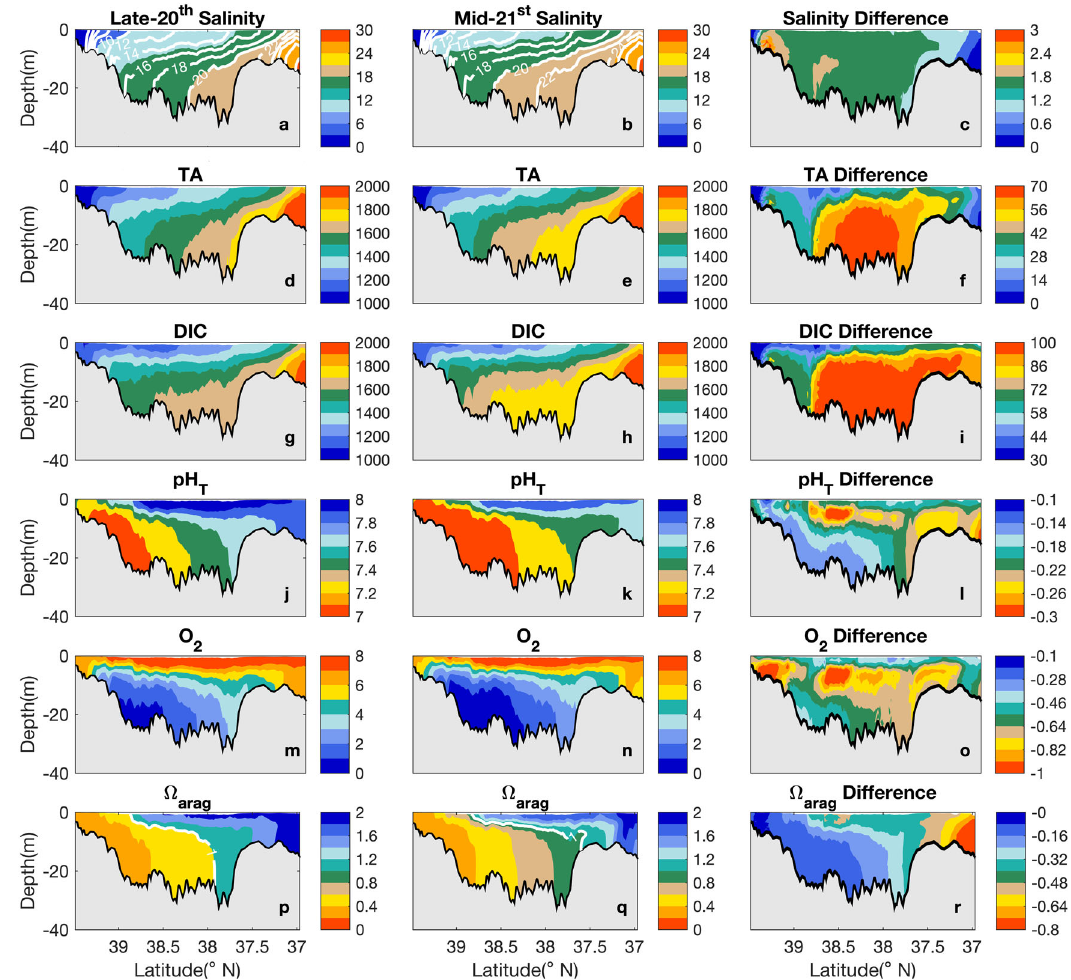
Fig. 1 Projected changes in carbonate chemistry parameters in Chesapeake Bay between the late-20th and mid-21st century. Along-channel distributions of summer mean (June to August) salinity (psu, a – c ), TA (Total Alkalinity, μ mol kg − 1 , d – f ), DIC (Dissolved Inorganic Carbon, μ mol kg − 1 , g – i ),